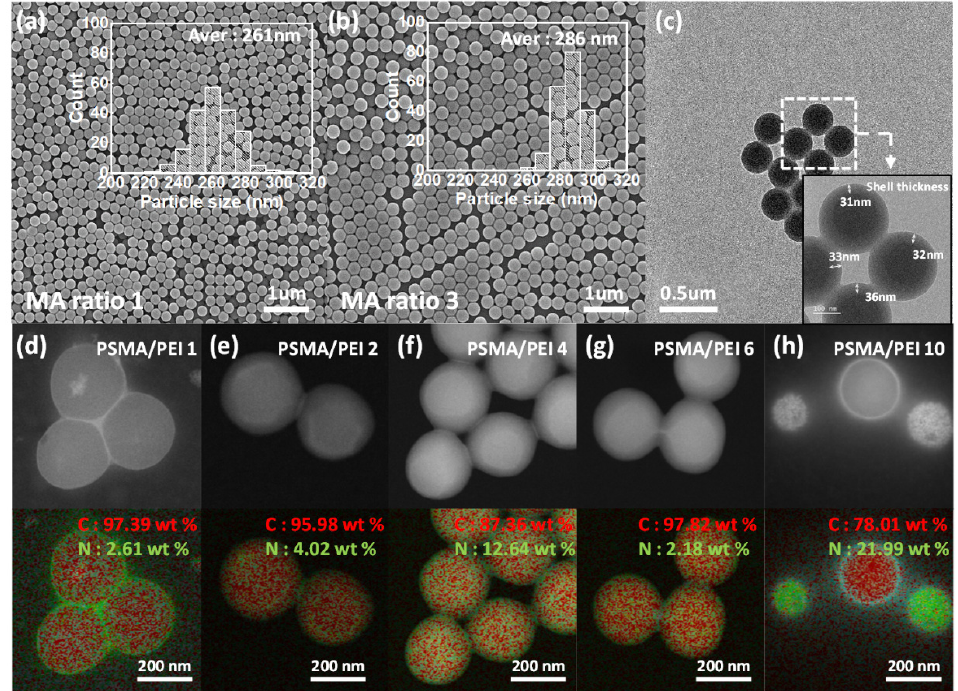
Figure 1. ( a , b ) SEM images of PSMA nanoparticles prepared with different maleic anhydride (MA) ratios; ( c ) TEM image of PSMA/PEI core–shell nanoparticles; ( d ) EDS mapping of the carbon and ratios; ( c ) TEM image of PSMA / PEI core–shell nanoparticles; ( d ) EDS mapping of the carbon